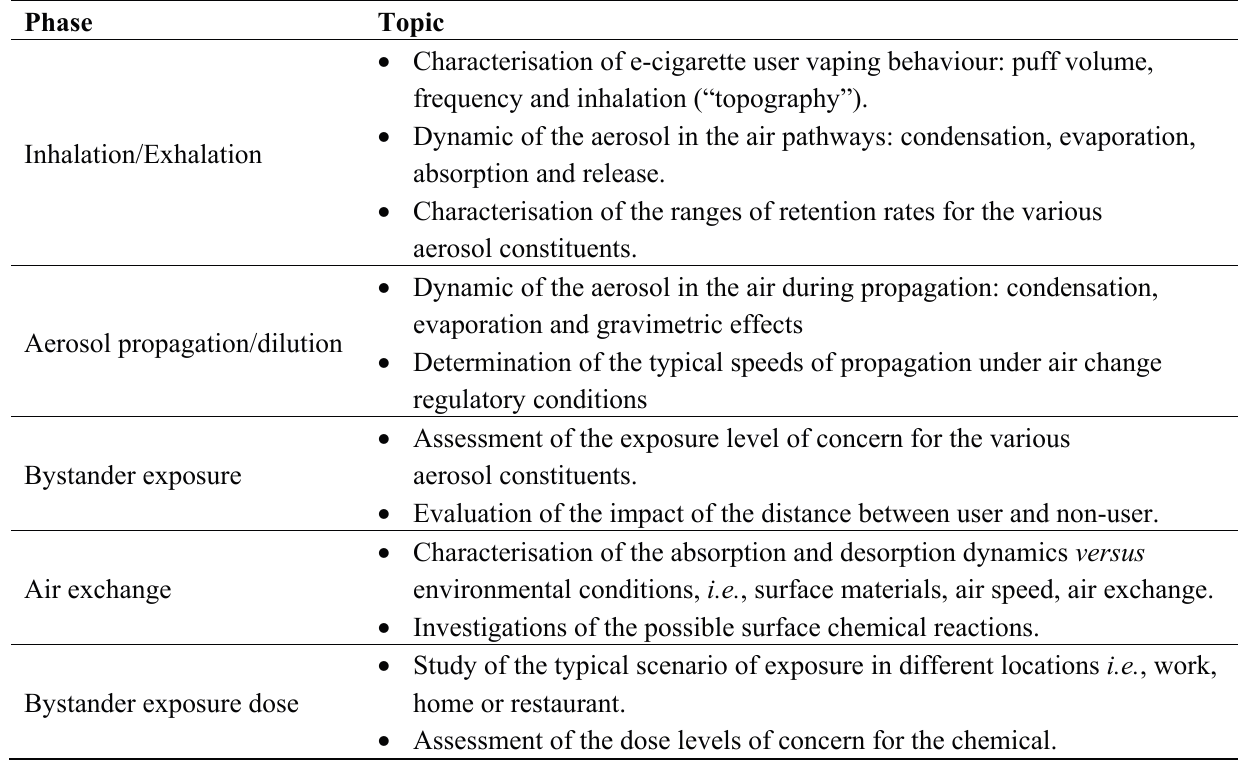
Table 2. Needs identified for further experimental